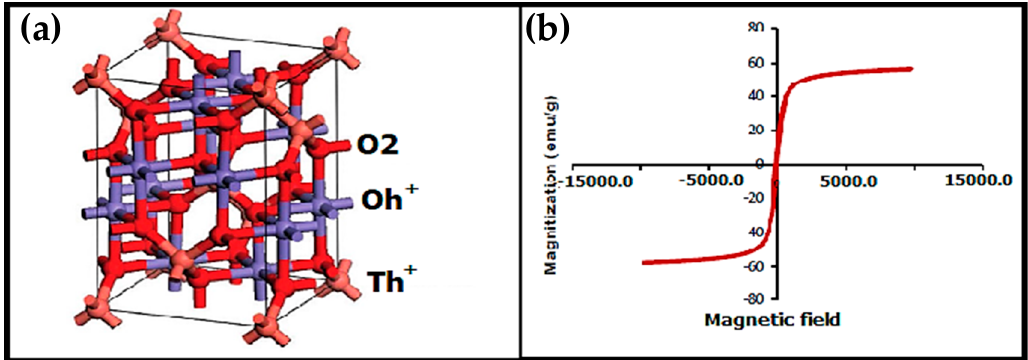
Figure 6. ( a ) Crystal structure of CuFe 2 O 4 ; ( b ) magnetization curve of M/nanocat-CuFe 2 O 4 . Catalysts 2020 , 10 , x FOR PEER REVIEW